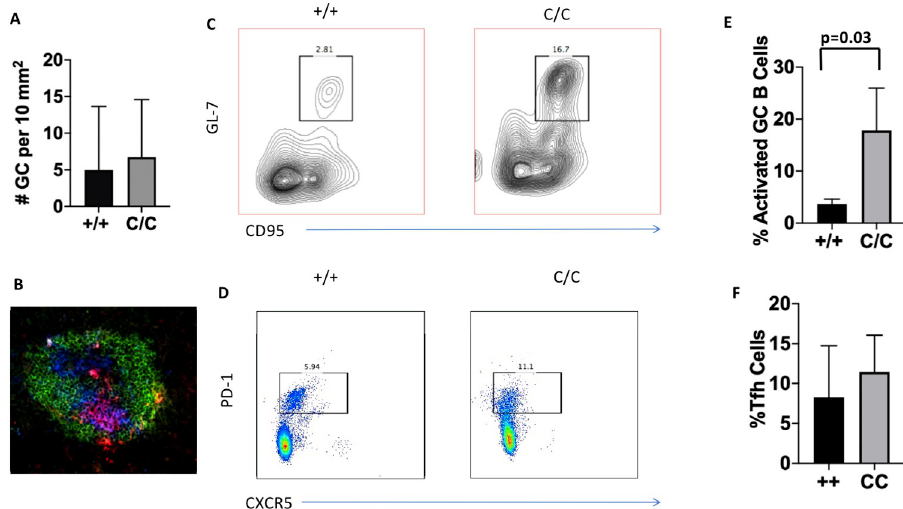
Fig 3. Increased levels of activated B cells in spleens of the POLB Y265C/C mice. A. The numbers of germinal centers are similar in the POLB +/+ mice and POLB Y265C/C mice. B. Representative example of a germinal center. Activated B cells stained with antisera raised against lectin PNA are green; T-cells are stained with antisera raised against CD4 in blue; cells staining for IgD-PE are red. C. Representative FACs plot of GL7+CD95+ cells (activated B cells). D. Representative FACs plot of PD-1+CXCR5+ Tfh cells. E, F. Quantification of activated B cells and Tfh cells, respectively. T-tests were used to determine if the means of each of the two groups were significantly different from each